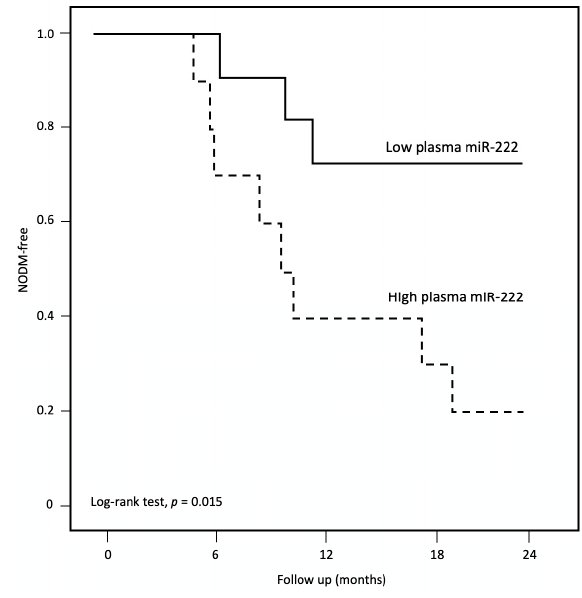
Figure 4. Kaplan–Meier curve of NODM in non-DM patients.